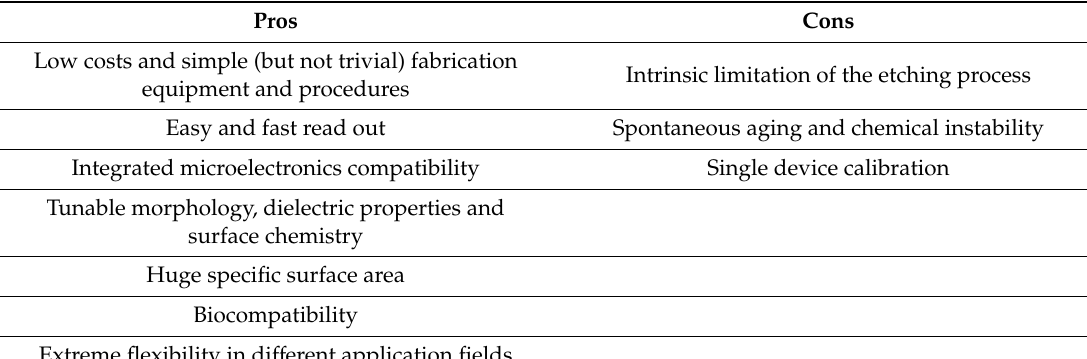
Table 2. Summary of pros and cons of PSi technology.